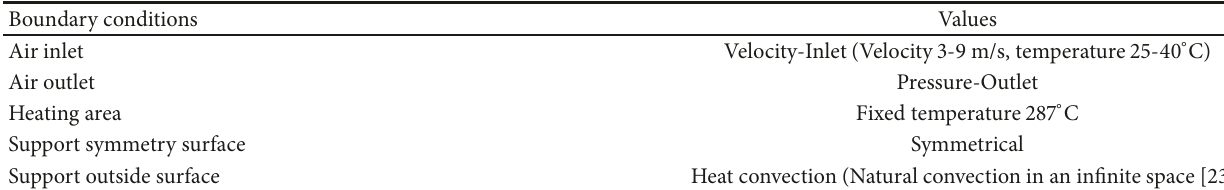
Table 3: The boundary conditions of calculation